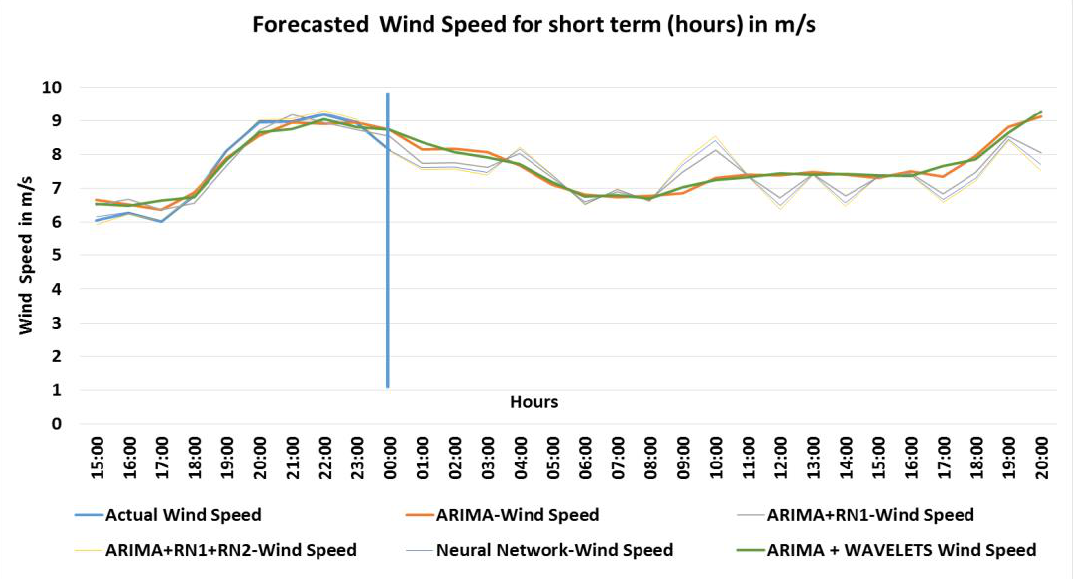
Figure 11. Generated power expected. Short-term (hours) in KW. The generated power varies according to the expected wind speed, for the selected generator. For this generator can be generated a power of up to 40 kW. This power can be increased taking into account the speed and also adopting a wind generator of more capacity. The variation in the power generation prediction behavior was smoother than the ultra-short prediction, but there was still a variation of approximately 15 kW from the range of 8–10 h and a decrease in the same proportion in the 10 h for 12 h interval This forecast horizon is important for planning the economic load dispatch, reasonable load decisions and operational safety in the electricity market.